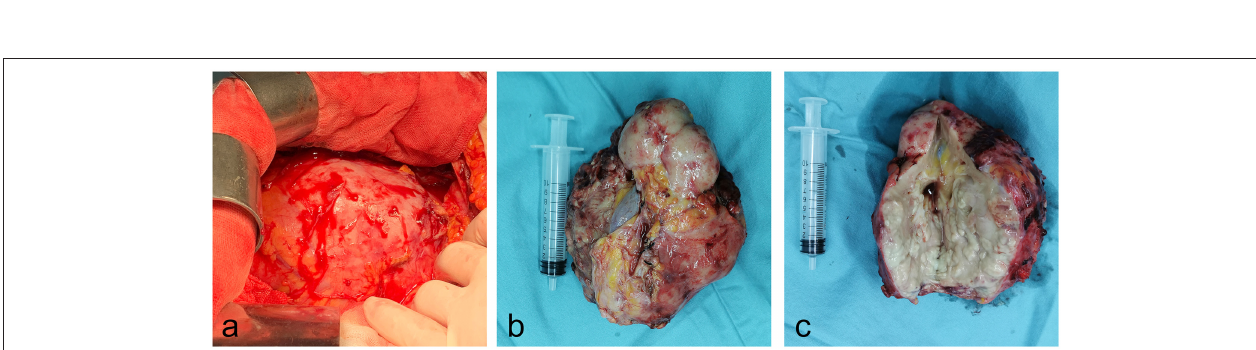
FIGURE 4 | (A,B) Bilateral ureteral and bilateral hydronephrosis decreased gradually, and the left renal mass increased continuously. (C) The bladder wall was continuously thickened, and the bladder volume was further reduced.